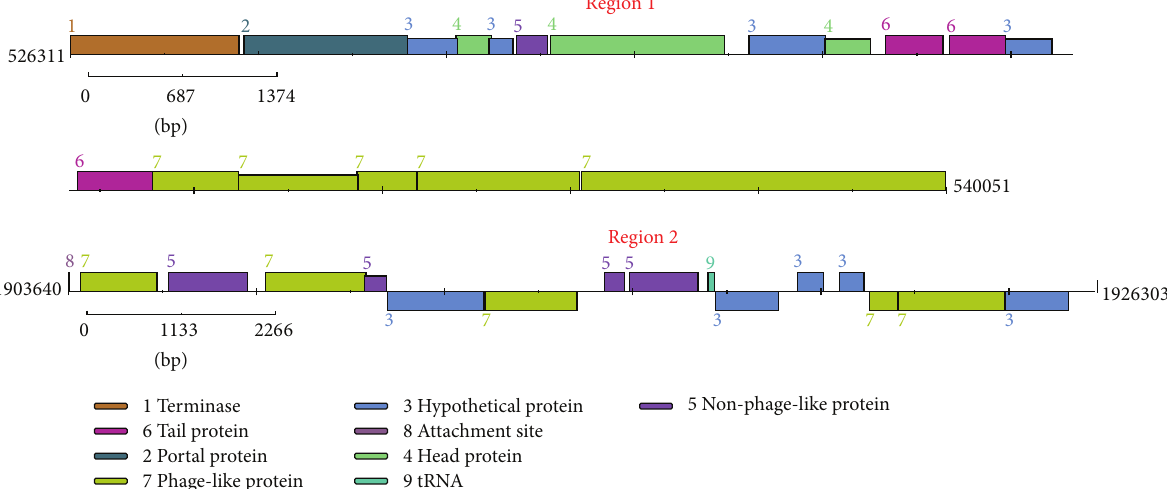
Figure 5: Genomic organization of two putative phage like regions. Scales are described below the chromosomal region and legends are described at the bottom. Table 4: SNPs detected in other B. melitensis isolates and B. abortus 2308 with respect to Bm IND1. Species Synonymous SNPs Nonsynonymous SNPs Total number of